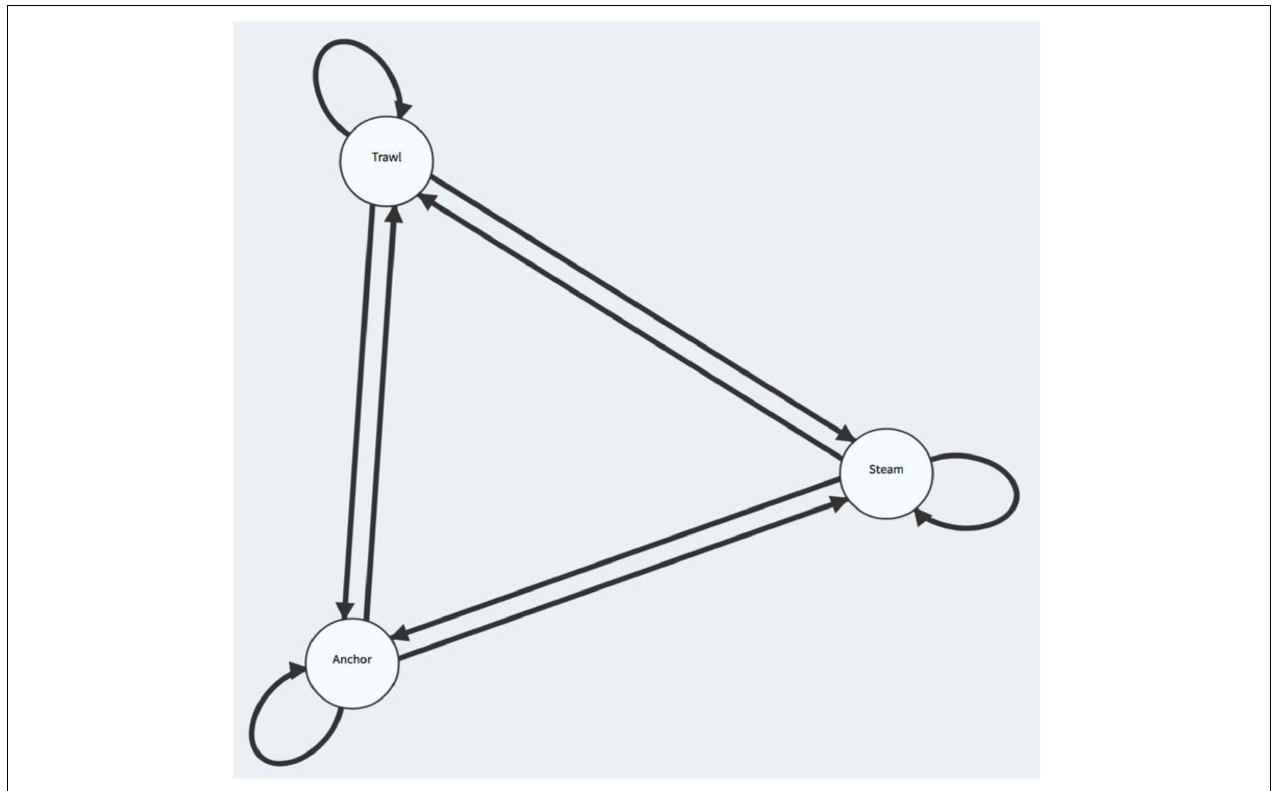
FIGURE 1 | States and potential transitions between states in a hidden Markov model. Arrows represent potential transitions in states between times, which are estimated from the observations.